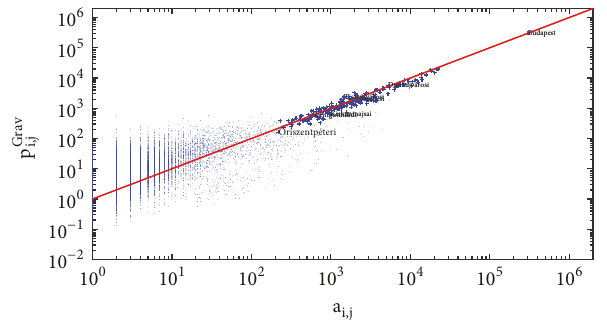
Figure 8: Comparison between the number of the edge weights 𝑎 [2] 𝑖,𝑗 and their estimated values 𝑝 [2] 𝑖,𝑗 generated by the gravity null model at level LAU 1 of the settlement hierarchy when 𝐼 𝑜𝑢𝑡 𝑖 = 𝑇𝐷𝐼 𝑖 and = 𝑇𝐷𝐼 𝐼 𝑖𝑛 𝑗 .The+symbolsrepresenttheinnerconnectionsthatform 𝑗 a separate